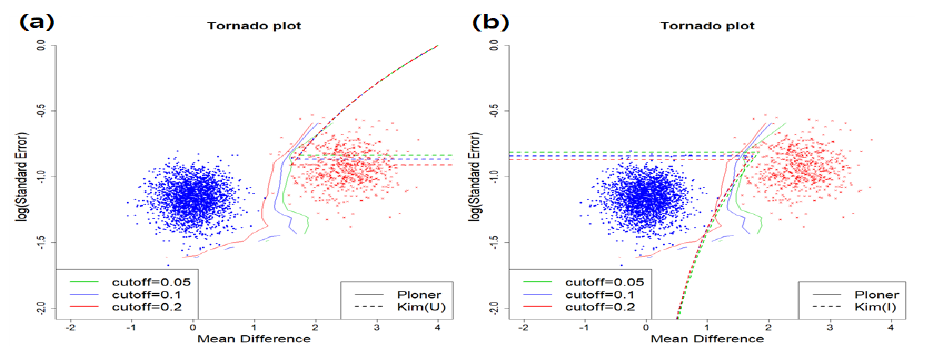
Figure 2. Basic scenario and one-sided alternative: estimated fdr2d for union null ( a ) and intersection null ( b ).